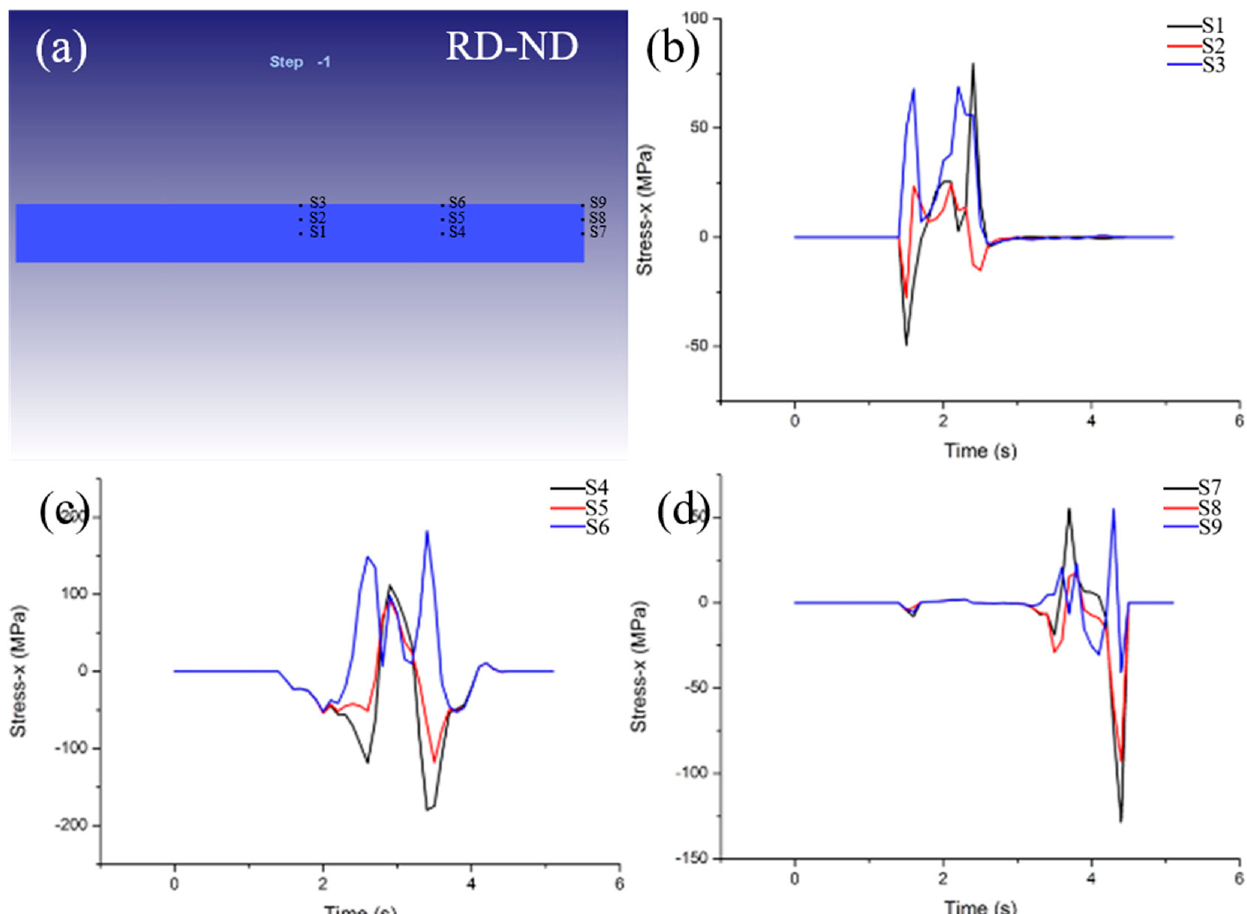
Figure 11. Distribution of characteristic points on RD − ND plane ( a ), the additive stress distribution along the RD direction of 9 selected feature points on the RD − ND plane at 1400 °C and 20% reduction ( b – d ). Three characteristic points (S4, S5 and S6) with different thickness in the middle